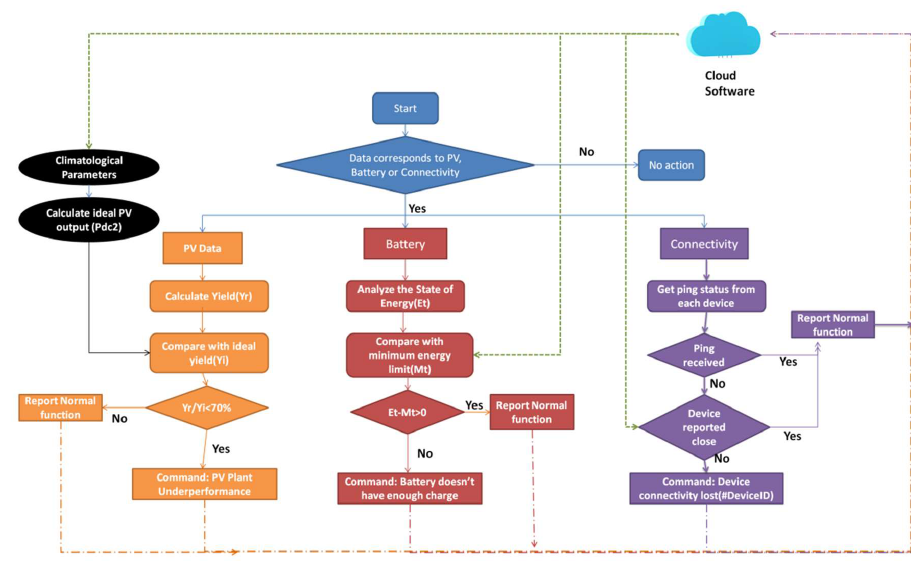
Figure 7. Decision chart of the proposed feedback mechanism.